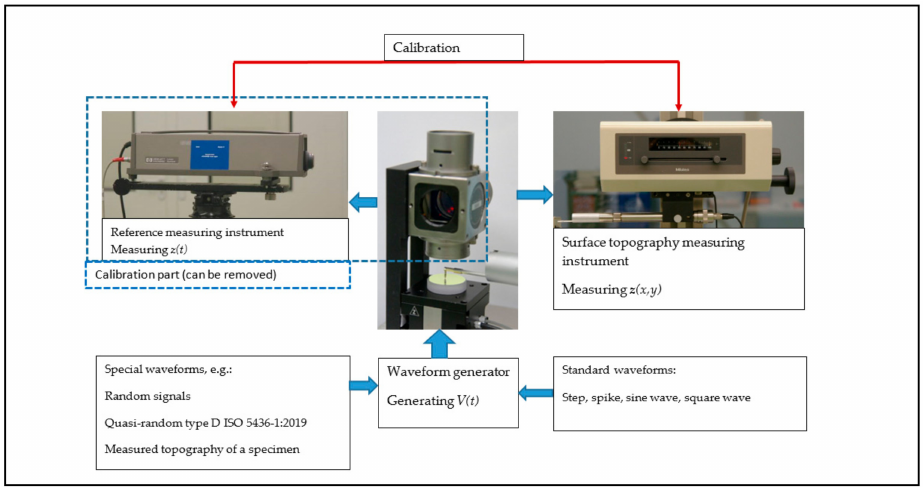
Figure 11. Scheme of a dynamic probe calibration set-up. The calibration part (indicated by a dotted line) can be removed after the system is